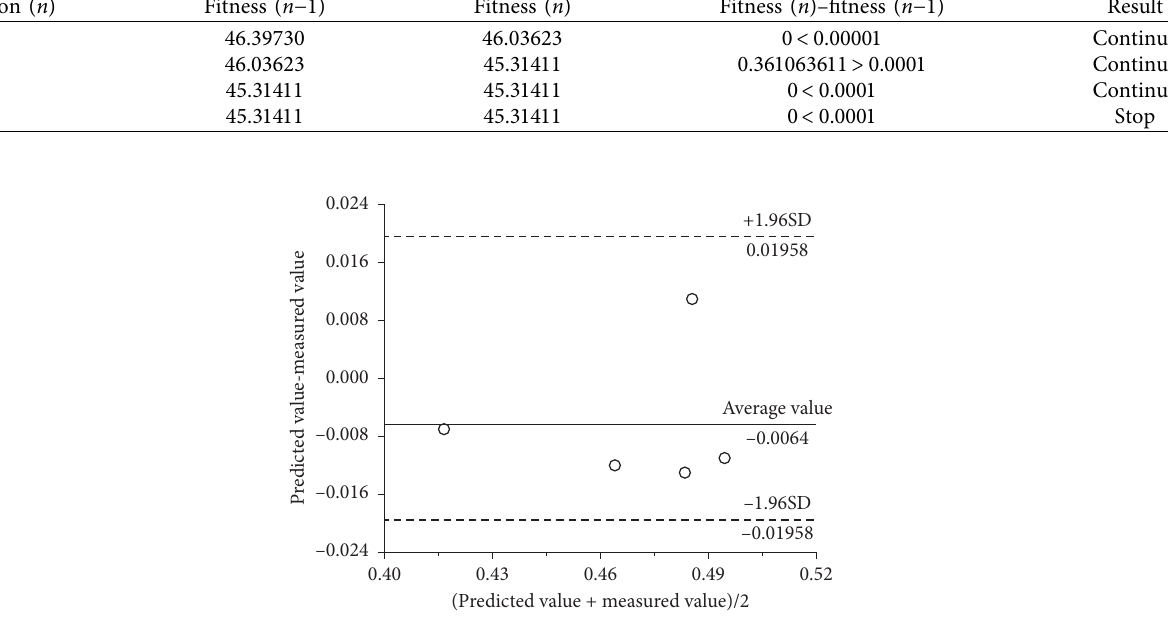
Figure 5: Bland–Altman analysis of the predicted values and actual values. Table 7: Calculation results of the 10-fold